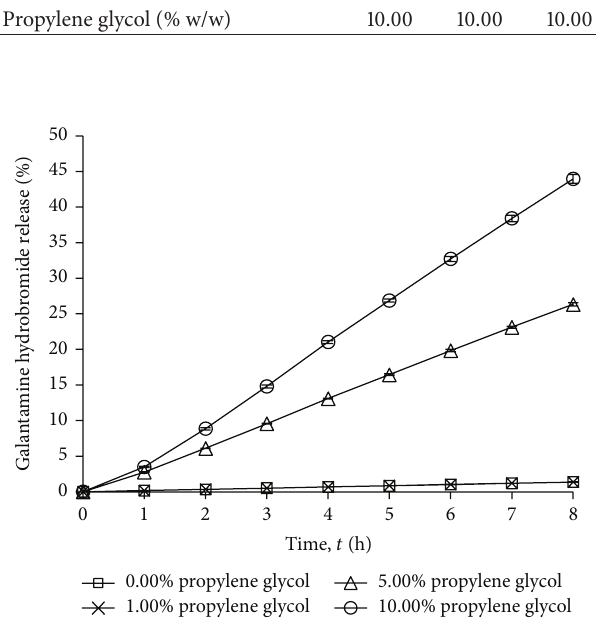
Figure 5: Drug release profile of gel drug reservoirs with different propylene glycol percentage (mean ± S.D.; 𝑛 = 3 ).